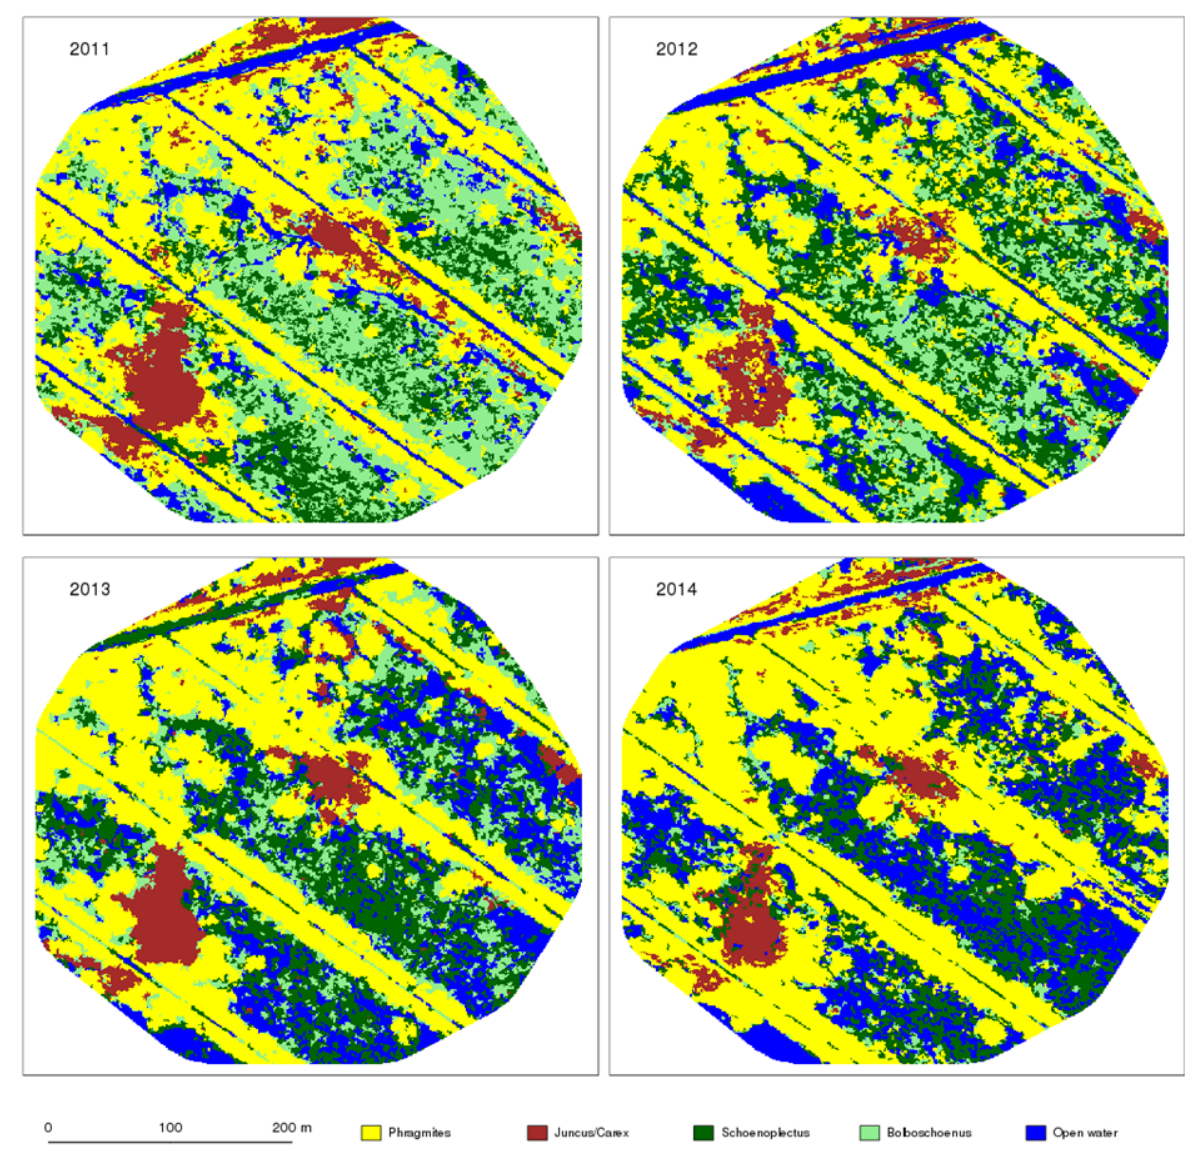
Figure 2. Vegetation maps of the study area generated from aerial images and plot-based vegetation